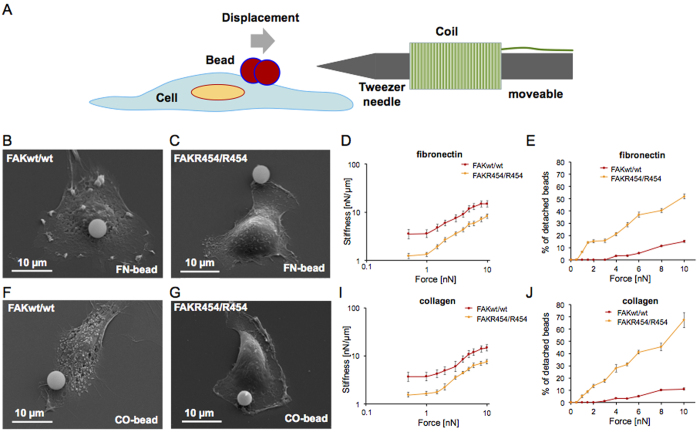
Stiffness and adhesion strength are reduced substantially in FAKR454/R454 as compared to FAKwt/wt cells.(A) Scheme of magnetic tweezers setup. Representative scanning electron microscopic images of FAKwt/wt and FAKR454/R454 cells, binding beads coated with fibronectin (B and C, respectively) or collagen type I (F and G, respectively). Prior to application of defined forces through magnetic tweezers, beads were bound to cells for at least 30 min. Measurements with fibronectin- (D) and collagen-coated beads (I) show decreased stiffness of FAKR454/R454 cells (orange) compared to FAKwt/wt cells (red). Insufficient adhesion strengthening of FAKR454/R454 cells is revealed by high incidence of detachment/loss of both fibronectin- (E) and collagen-coated beads (J) at low forces, which was not observed for wild-type FAK protein expressing control cells. Values of stiffness and adhesion strength are expressed as mean ± SD (n = 3, > 140 cells for each condition).